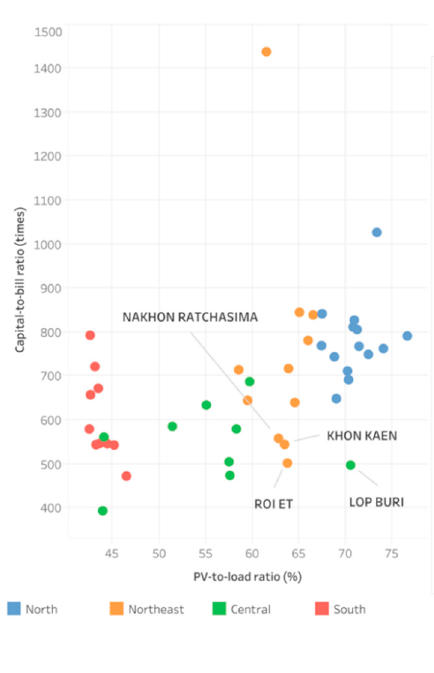
Figure 13. SGS customer investment hotspots (under a net billing compensation scheme with a 1 THB/kWh buyback rate).